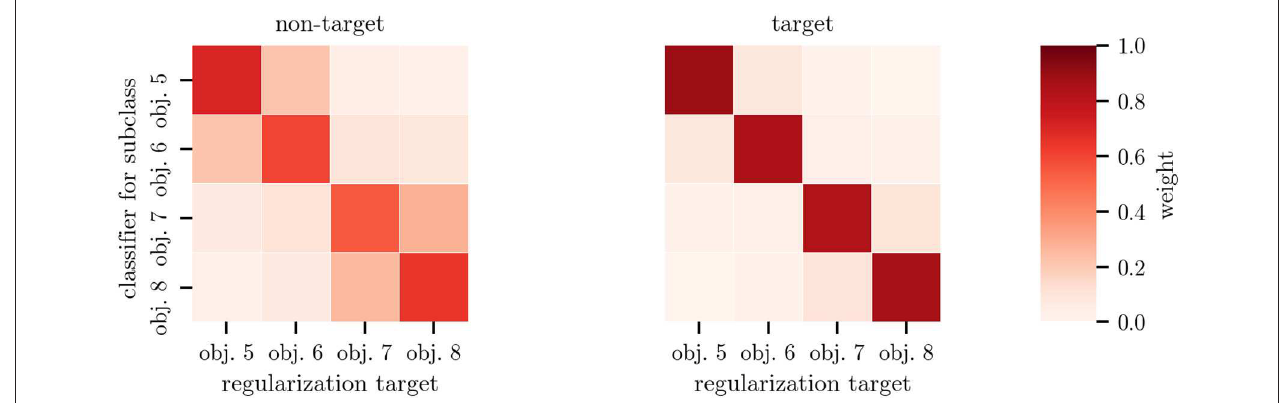
FIGURE 7 | Mean regularization weights α for heterogeneous objects. Each row corresponds to the weights of a single subclass-specific classifier. On the left, regularization weights for the mean of the non-target class are shown whereas the corresponding weights for the target class are shown on the right. Entries can be viewed as sample weights of the data of the corresponding subclass. Note the object similarities indicated by the block structure in this figure compared to the stimulus appearances in Figure 2 . The weights have been averaged across all participants of datasets HET1 and HET2 with classifiers trained on 100% of the